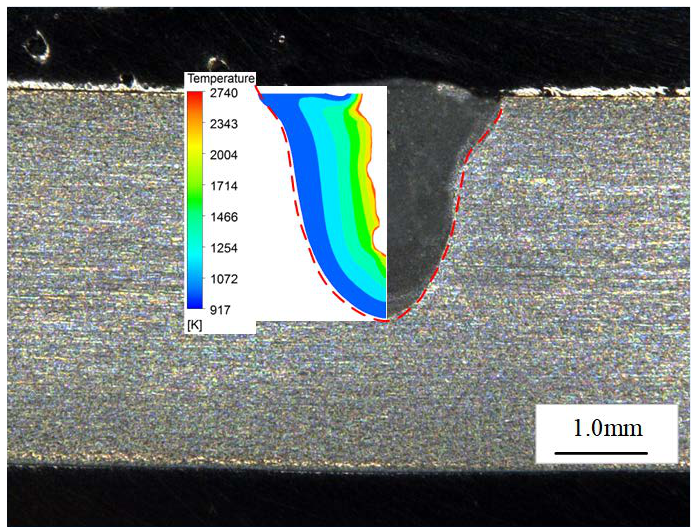
Figure 2. Comparison of the weld seam shape (right) and the simulated molten pool (left) for laser welding with preheating temperature of 300 K (ambient temperature).